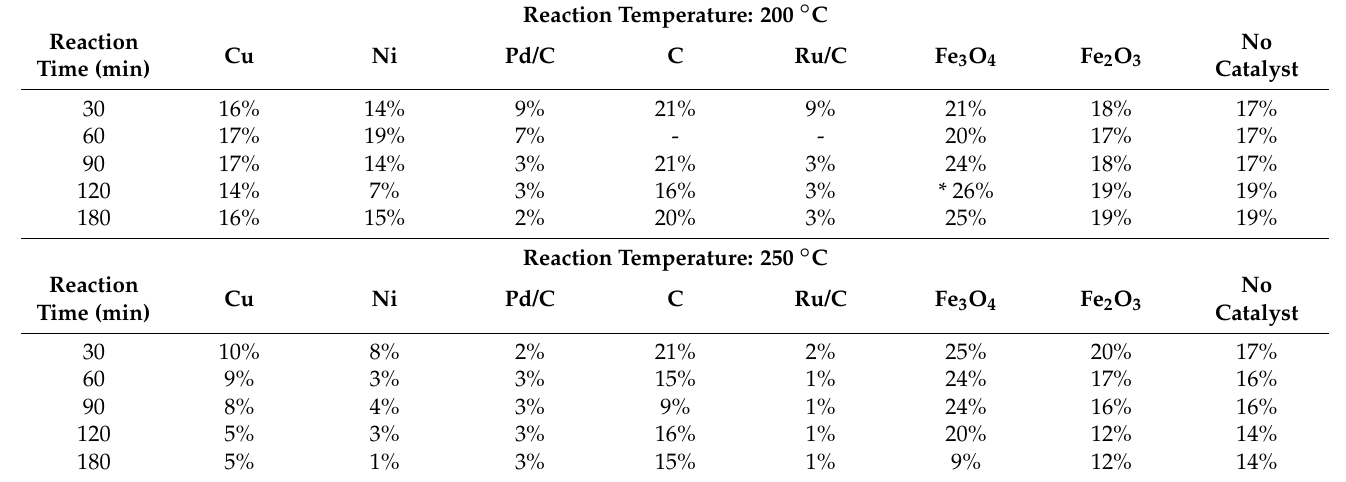
Table 4. Yields of formic acid obtained after the hydrothermal reaction of NH 4 [H 2 NCO 2 ] with glucose in the presence of catalysts. The higher yields obtained after the hydrothermal reactions are marked with an asterisk